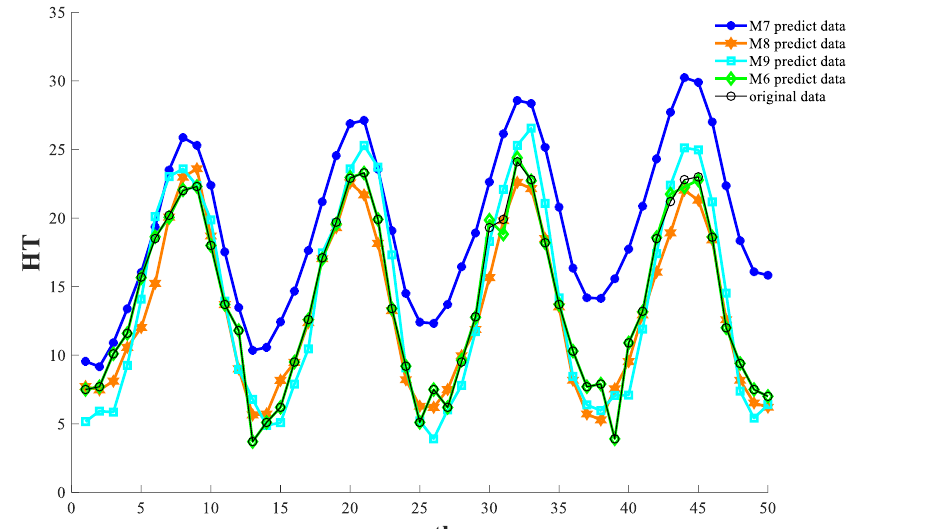
Figure 19. Predicting effect of the observed and predicted highest temperature (unit: °C) using M6–M9 models.